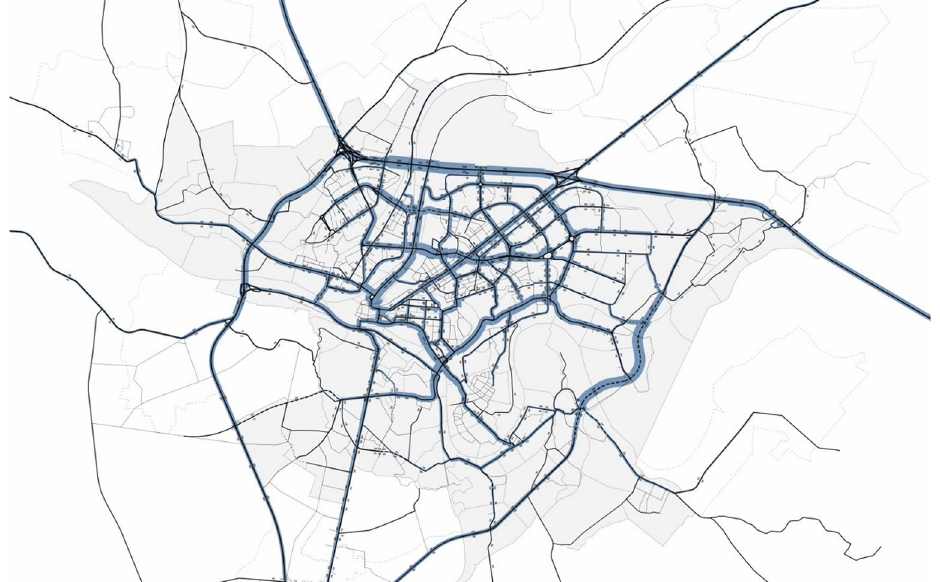
Figure 4. The cartogram of the forecasted transport flows in Kaunas